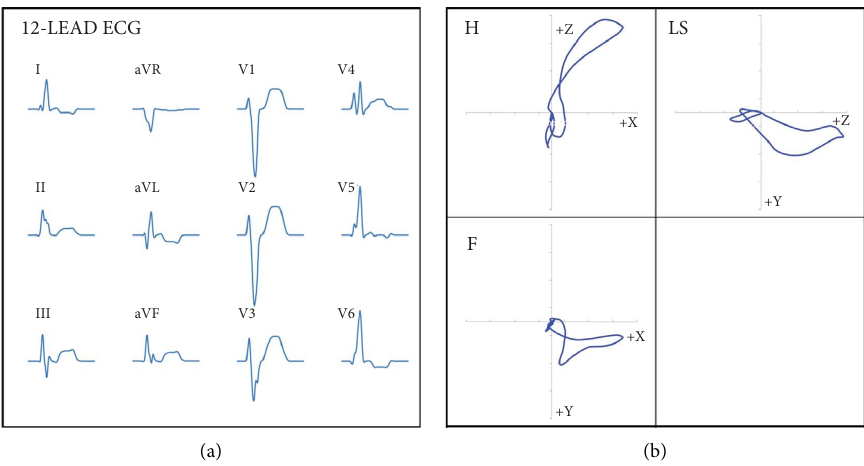
Figure 1: Results of the computer simulation: Typical LBBB patterns observed after slowing the conduction velocity in left ventricular myocardium without blocking the onset of left ventricular activation, i.e. without simulating the block in the left bundle branch. 12-lead ECG (a), vectorcardiogram (b), (H) horizontal plane, LS: left sagittal plane, (F) frontal plane. Adapted from: Bacharova L, Szathmary V, Mateasik A. Electrocardiographic patterns of left bundle-branch block caused by intraventricular conduction impairment in working myocardium: a model study. J Electrocardiol. 2011; 44:768–78. With